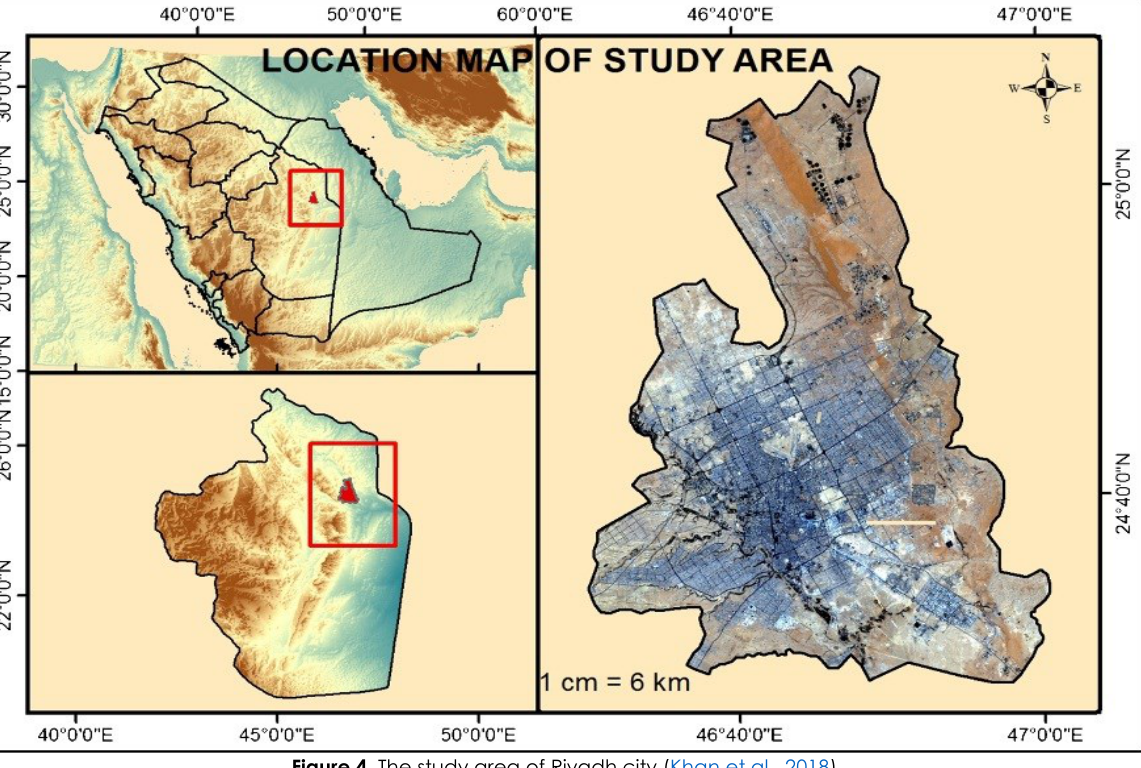
Figure 4. The study area of Riyadh city (Khan et al.,